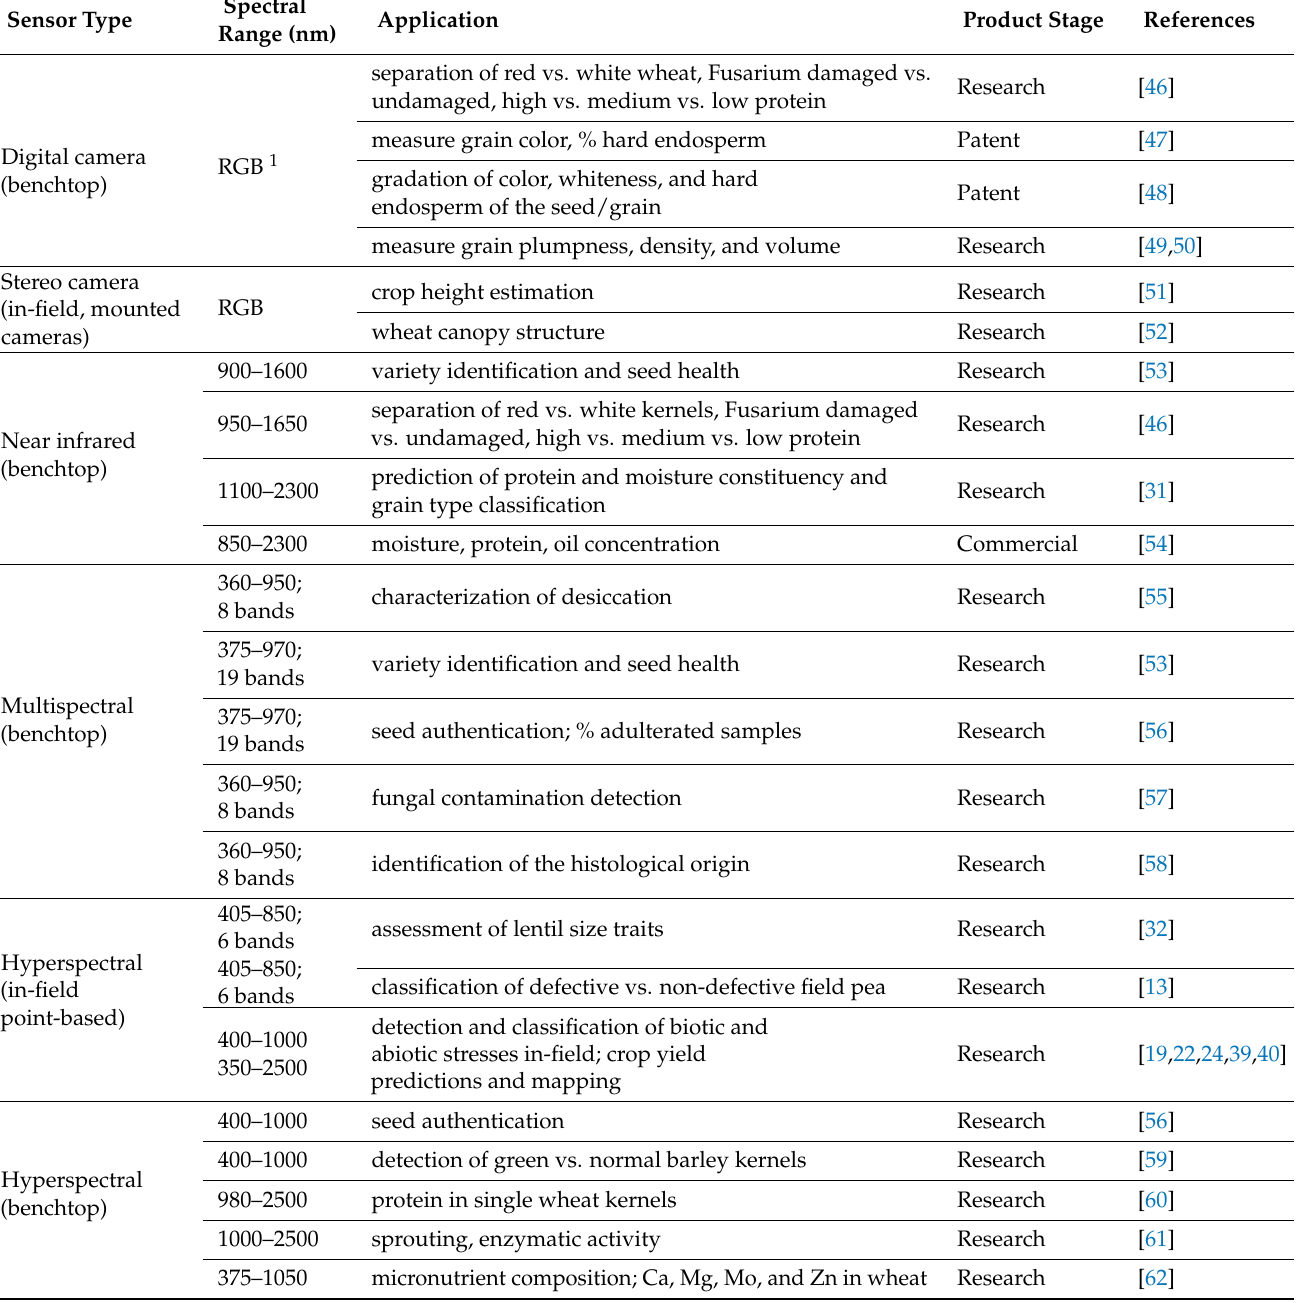
Table 1. List of sensor technologies and examples of their applications in evaluating grain quality associated with measuring traits important for on-farm